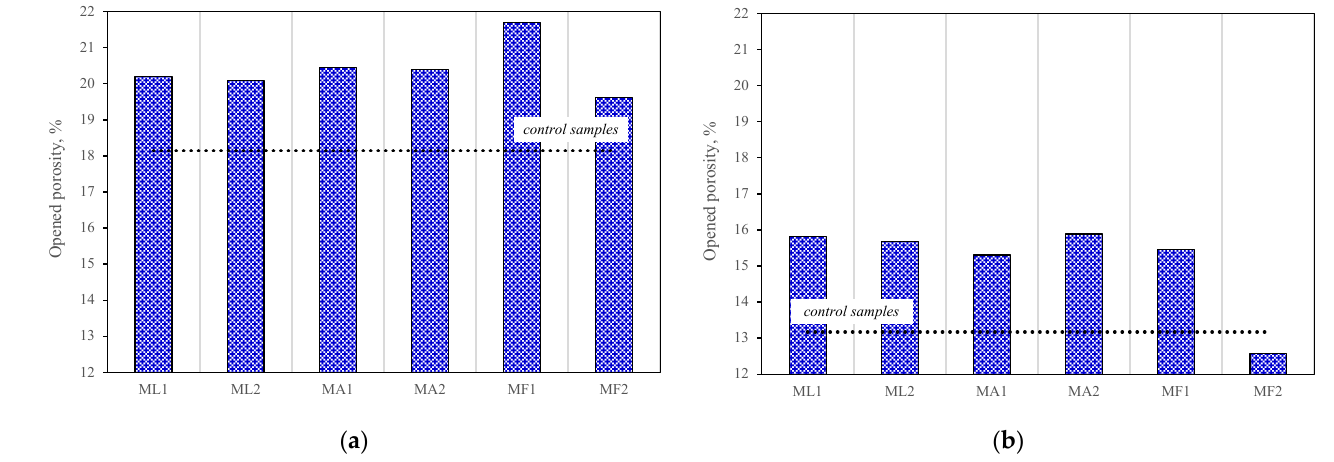
Figure 10. Open porosity of mortars No 2: ( a ) after 28 days; ( b ) after 90 days